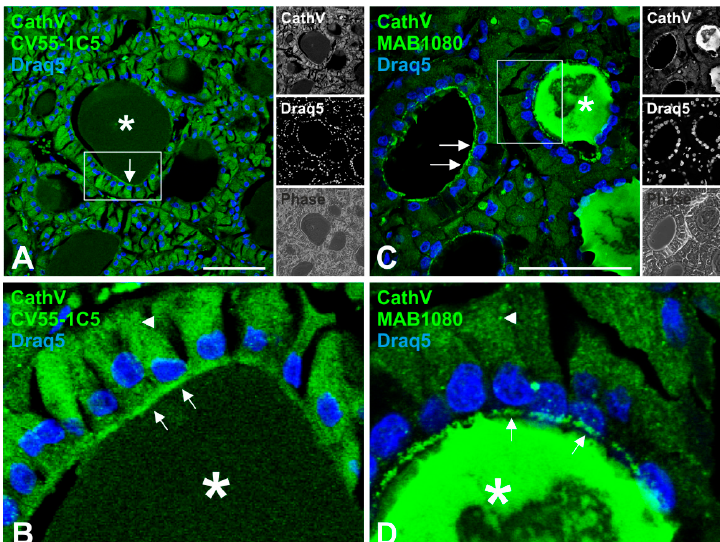
Figure 1. Immunohistochemistry of cysteine cathepsin V in human thyroid tissue. Human thyroid tissue sections were immunolabeled with different cathepsin V-specific antibodies (green signals), namely, anti-human cathepsin V CV55 1C5 ( A , B ) that exclusively immunoreacts with the proform of cathepsin V, and anti-human cathepsin V MAB1080 ( C , D ) recognizing both the pro- and mature cathepsin V forms. Nuclei were counter-stained with Draq5 ™ (blue signals). Single-channel fluorescence and corresponding phase contrast micrographs are depicted as indicated. Cathepsin V-immunopositive signals were detected within the cytoplasm (arrowheads), at the apical plasma membrane (arrows), and dispersed within the follicle lumen (asterisks). Rectangular boxes in A and C denote regions magnified in B and D, respectively. Scale bars represent 50 µ m.